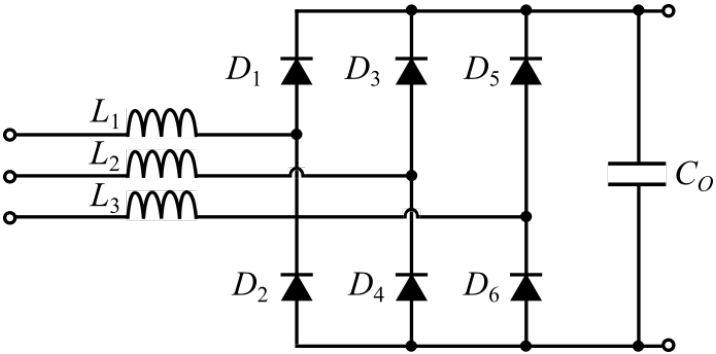
Figure 4. Three-phase passive rectifier.